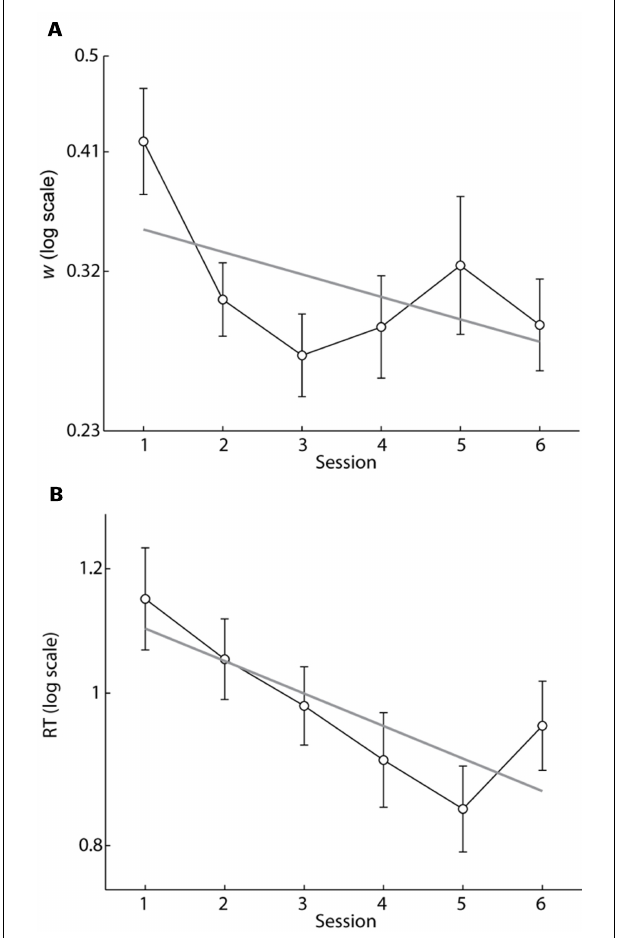
FIGURE 4 | (A) Mean w scores as a function of session number. Gray line is the best fit regression line to log( w ) ( b = − 0.047, p < 0.005) accounting for repeated measures. Note the rapid decrease in w between sessions 1 and 2 where trial-by-trial feedback was introduced. Acuity did not improve further after session 2, but was sustained after feedback was removed on session 6. (B) Mean of the median RT for correct responses as a function of session number. Gray line is the best fit regression line to log(RT) ( b = − 0.048, p (cid:3) 0.0001) accounting for repeated measures. RT continued to decrease with further training. Error bars indicate